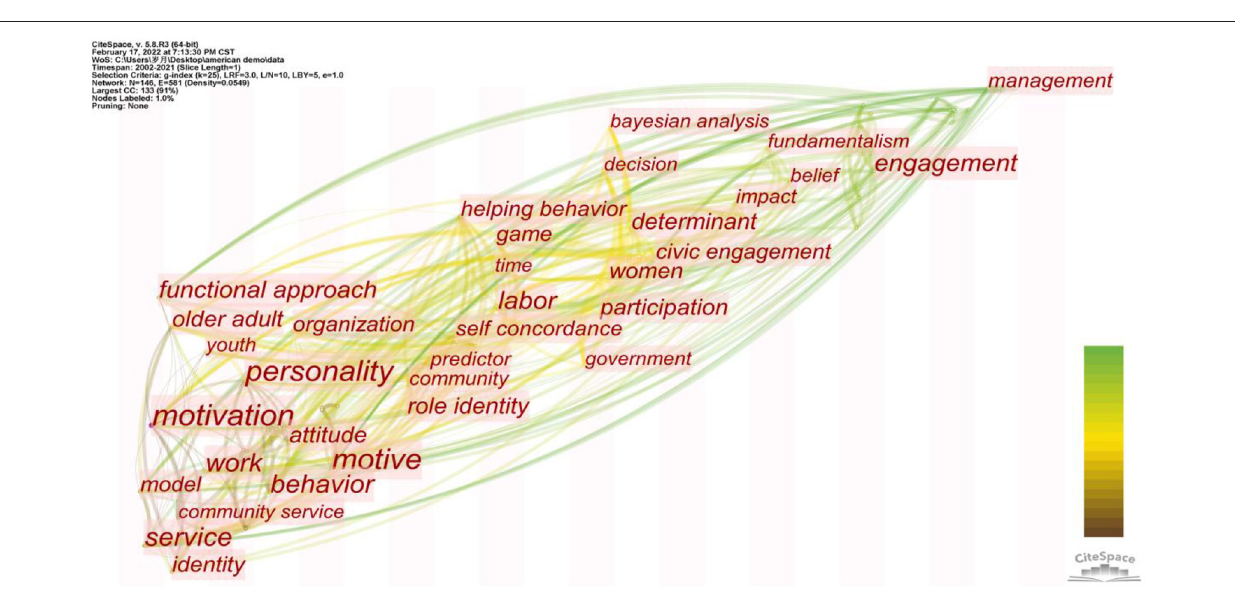
FIGURE 8 | Map of timezone view in American volunteer motivation